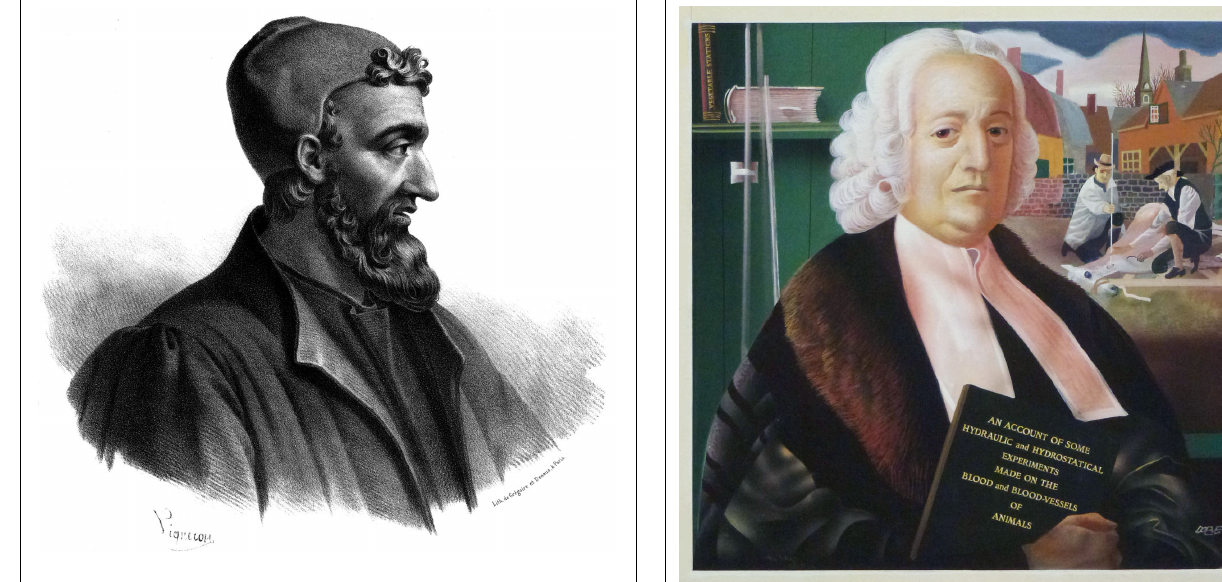
FIGURE 4 | Portrait of Galen of Pergamon (131–200AD). He wrote extensively about the pulse and used it for both the diagnosis and predicting the prognosis of disease. Source: National Library of Medicine (the history of medicine public domain image files). Lithograph by Pierre RocheVigneron (Paris: Lith de Gregoire et Deneux, ca. 1865).